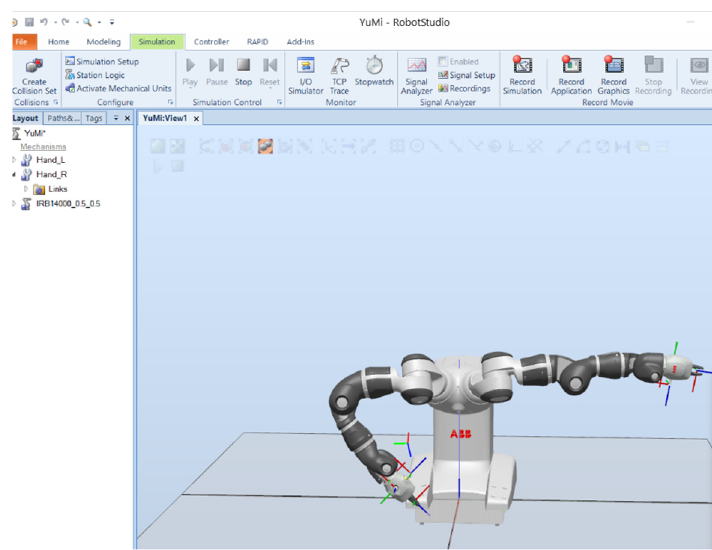
Figure 3. YuMi imitating movement in RobotStudio simulation.